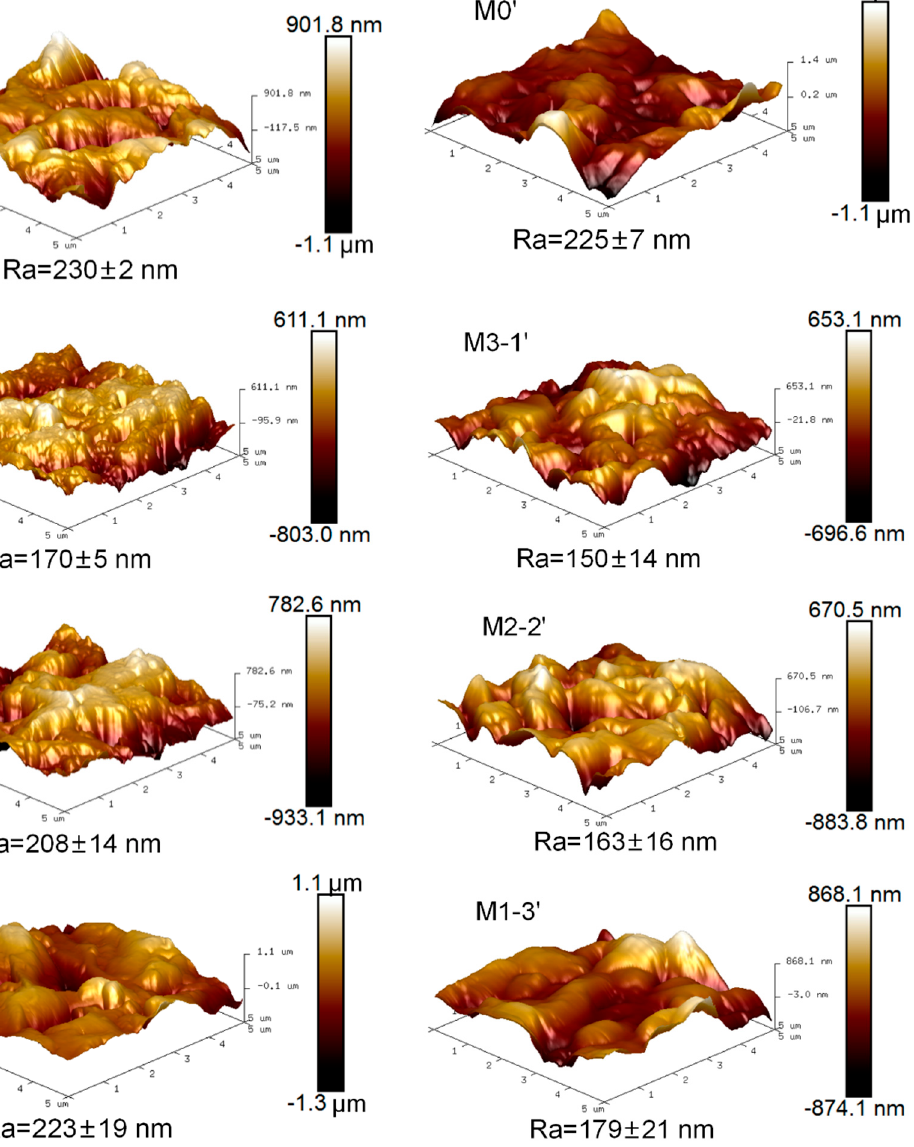
Figure 5. AFM photographs of membrane surfaces: ( left ) dry and ( right ) humid.